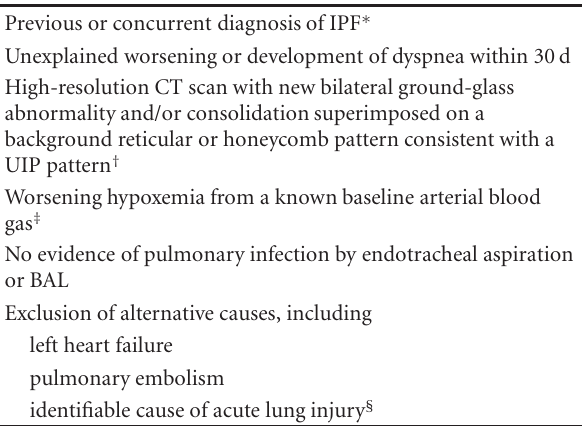
Table 1: Definition of acute exacerbation of IPF described by Hyzy et al.